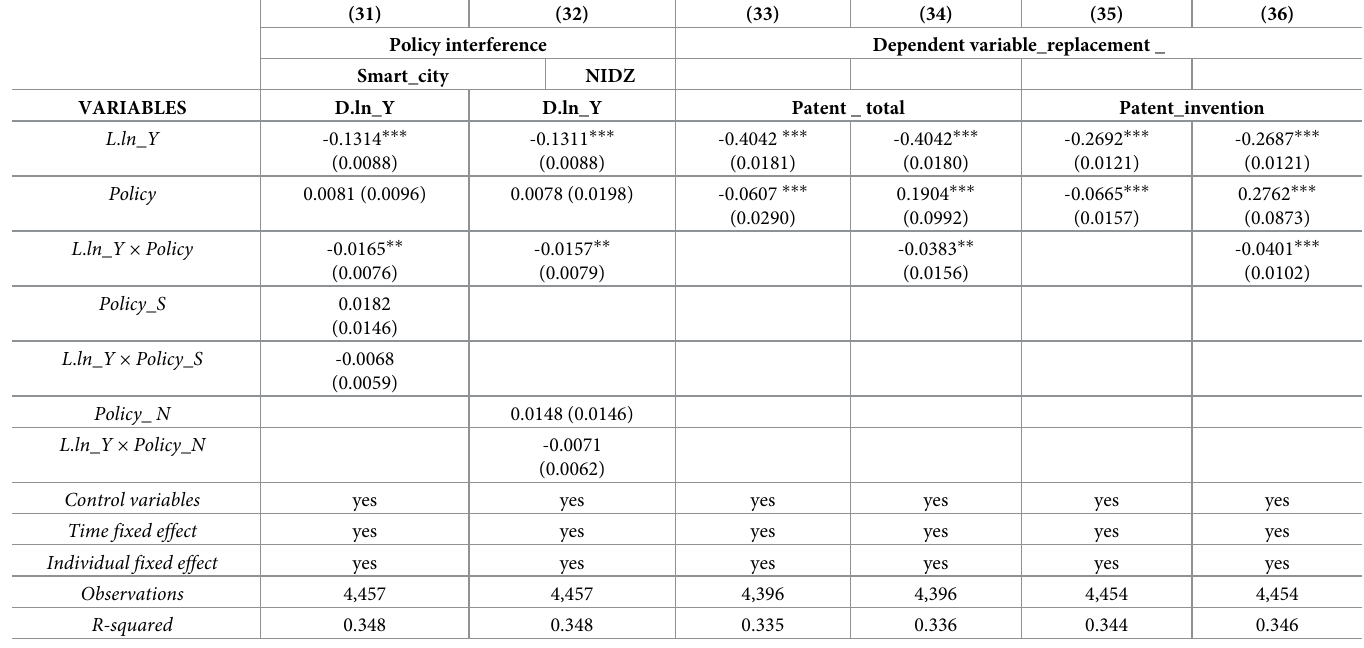
Table 8. Robustness